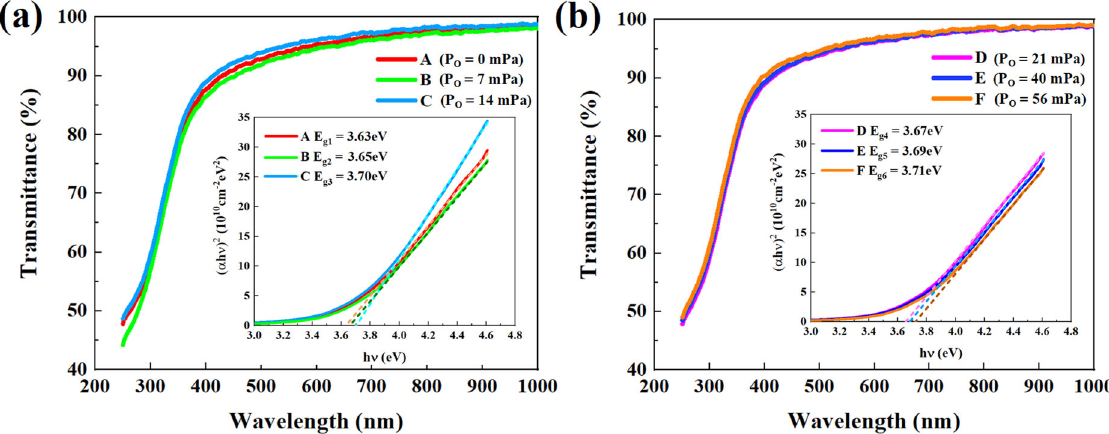
Figure 3. Transmittance spectra of ( a ) OD ‐ IGZO and ( b ) OR ‐ IGZO films; the insets show the fitting curves and the optical band gaps of OD ‐ IGZO and OR ‐ IGZO films, respectively. Here, the six samples (A, B, C, D, E, and F) were sputtered at P O = 0, 7, 14, 21, 40, and 56 mPa, respectively.